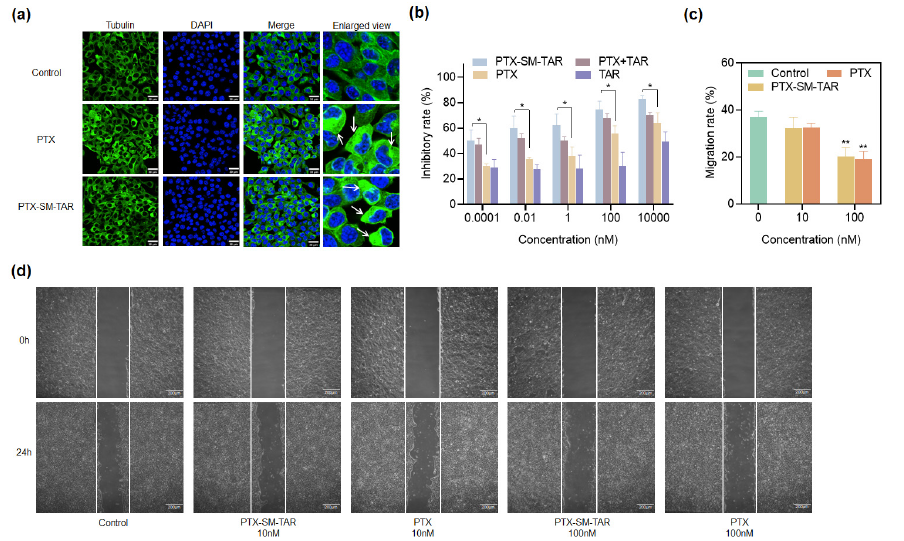
Figure 8. In vitro activity of PTX-SM-TAR NPs on 4T1-mCherry-Luc cells. ( a ) Confocal microscopy images of 4T1-mCherry-Luc cells after incubation with PTX and PTX-SM-TAR NPs for 24 h, the cell nuclei were stained with DAPI (blue), and microtubules were stained with the Tubulin-Tracker Green (green). The scale bar is 30 μ m. ( b ) Anti-proliferation effects of TAR peptide, PTX, PTX plus TAR peptide, and PTX-SM-TAR NPs at different concentrations against 4T1-mCherry-Luc cells (mean ± SEM, n = 3, * represents p < 0.05. ( c , d ) Statistical migration rates and images of 4T1-mCherry-Luc cells treated with different drug concentrations. The scale bar is 200 μ m (mean ± SEM, n = 3, ** represents p < 0.01).